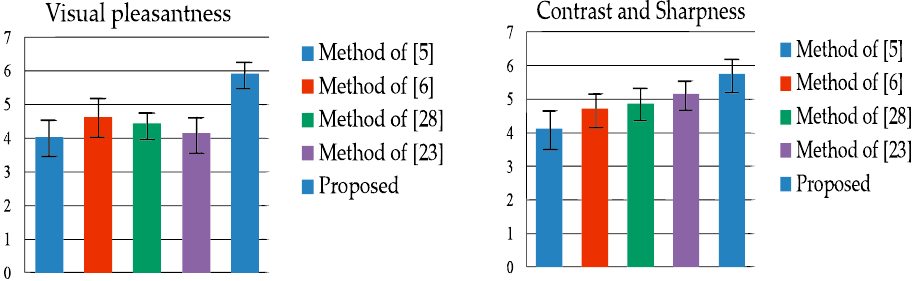
Figure 8. Results of the subjective test in terms of visual pleasantness and contrast / sharpness (average / standard deviation of the scores).